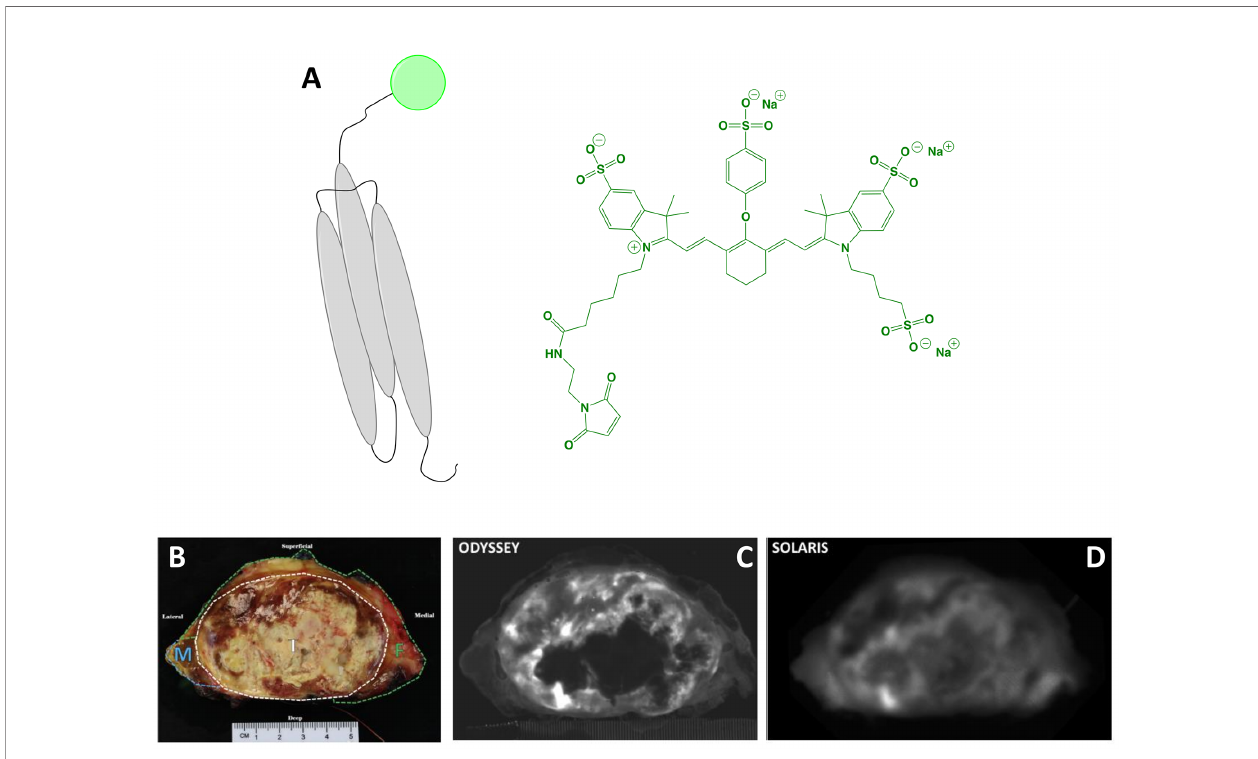
FIGURE 3 | ABY-029. Schematic* of the af fi body Z03115-Cys (targeting motif; gray) labeled with IRDye800 (dye, represented as a green circle). The chemical structure of IRDye800 maleimide is also shown (A) . Ex vivo sarcoma imaging with 237 m g (30 nanomoles) ABY-029 administered 1-3 h prior to surgery: white-light of resected primary (breadloaf) (B) , NIRF using a fl atbed, closed-box device (C) and NIRF using a wide- fi eld device (D) . Panels (B – D) are adapted from (51) with permission. *Not to